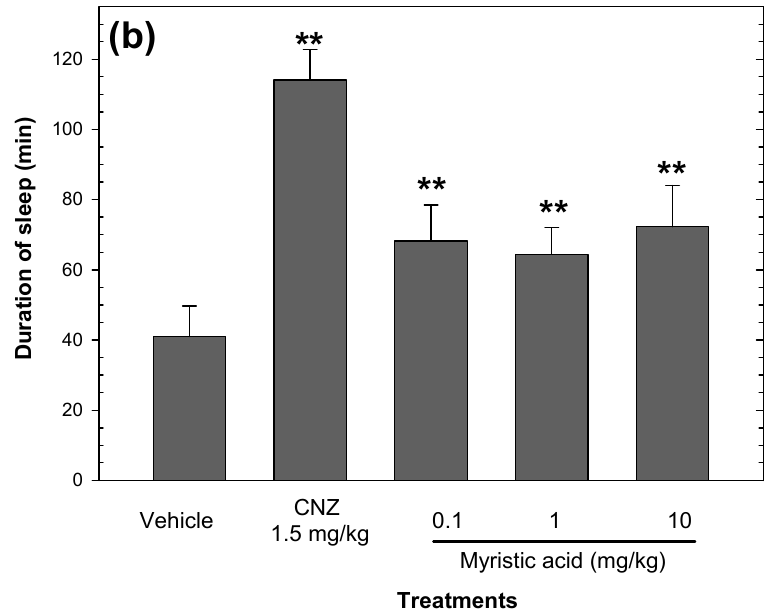
Figure 10. Sedative effects of myristic acid (0.1–10 mg/kg p.o.). The sedative effects of myristic acid were measured by the onset of sleep ( a ) and the duration of sleep ( b ) in the pentobarbital-induced sleep test. Clonazepam (CNZ) at 1.5 mg/kg p.o. was used as the positive control. Bars represent mean values (± SEM) for the experimental group. n = 8, ** p < 0.05 compared to the vehicle group.